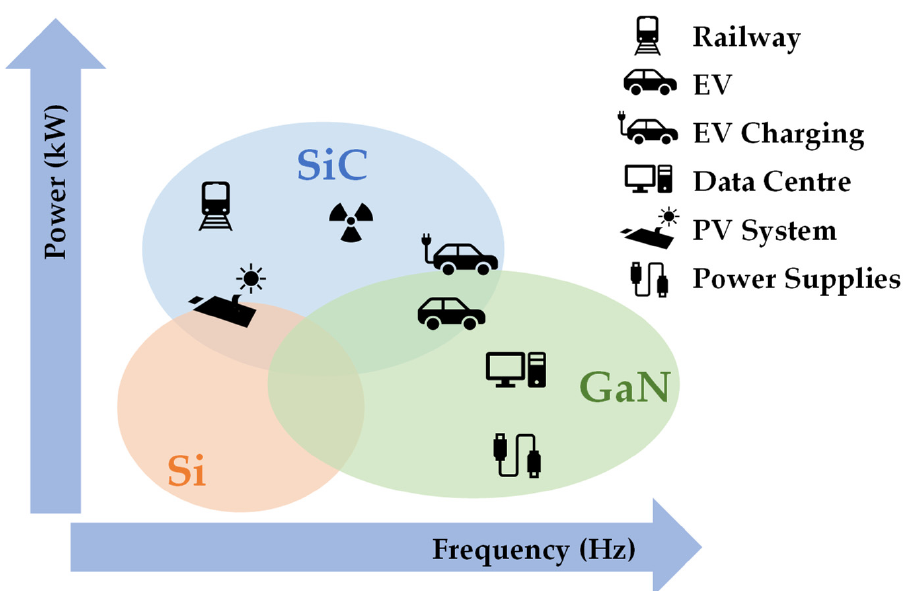
Figure 3. Emerging of WBG semiconductor devices in transportation applications. Adapted from [42].